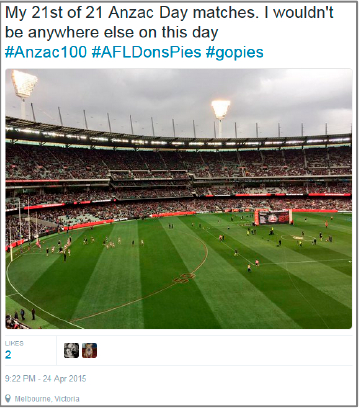
Figure 1. Example micro-blog with linked image categorized as a (WA) [12].